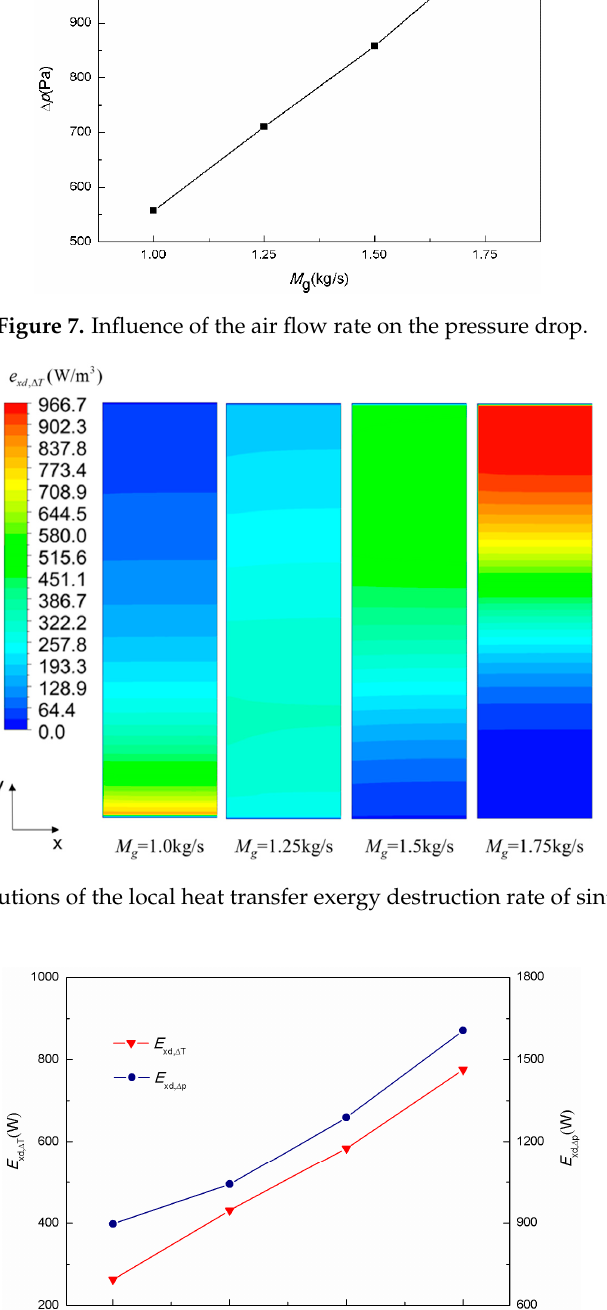
Figure 9. Influence of the air flow rate on exergy destruction caused by heat transfer and caused by fluid Figure 8. The distributions of the local heat transfer exergy destruction rate of sinter for different air mass flow rates.